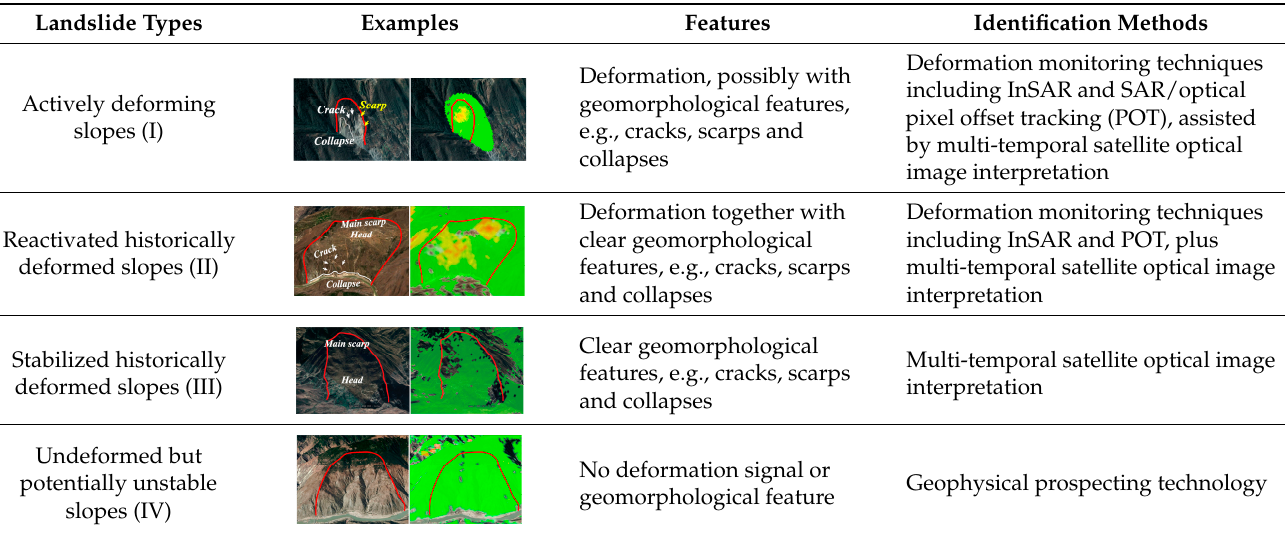
Table 2. Landslide classification and identification methods.